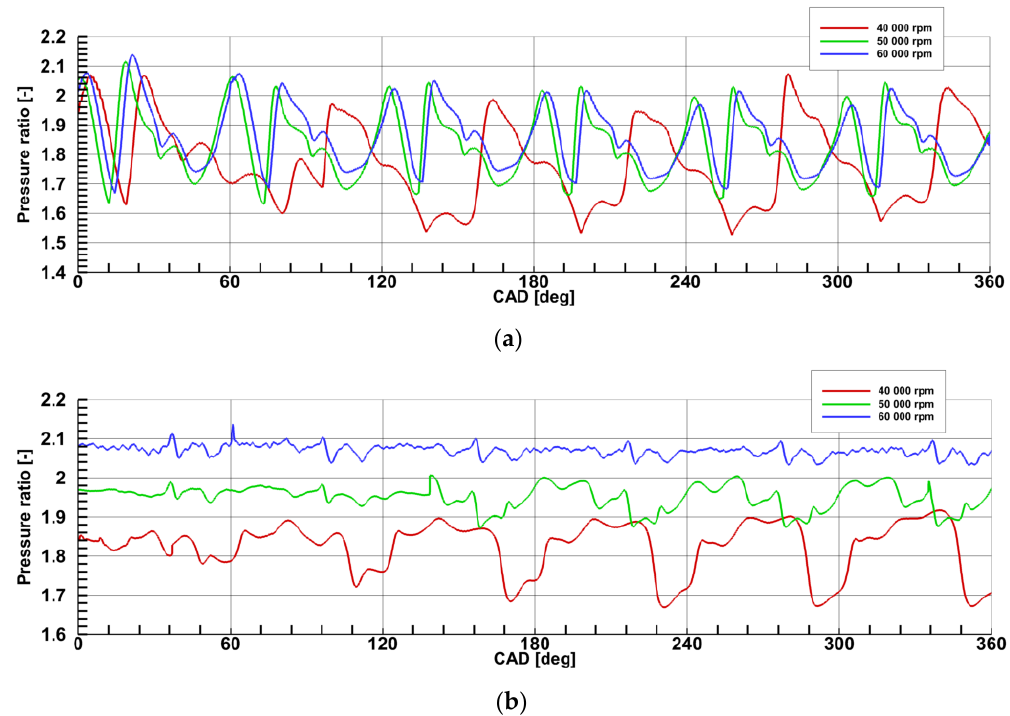
Figure 15. The pressure ratio at three different turbine speeds during the 3rd revolution of the crankshaft: ( a ) first-stage rotor; ( b ) second-stage rotor.